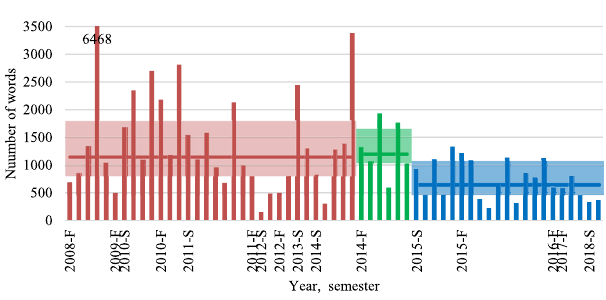
FIG. 2. An estimate for the number of words used to write all the feedback for each group. In the color graphic, red indicates the prerubrics period (before 2014-F), green indicates the intermediate period (the semester 2014-F), and blue indicates the rubrics period (from 2015-S on). Fifty percent of all reports fall within the respective shaded areas (the interquartile ranges). The lines indicate the respective medians. The labels on the horizontal axis indicate the year and semester [spring (S) and fall